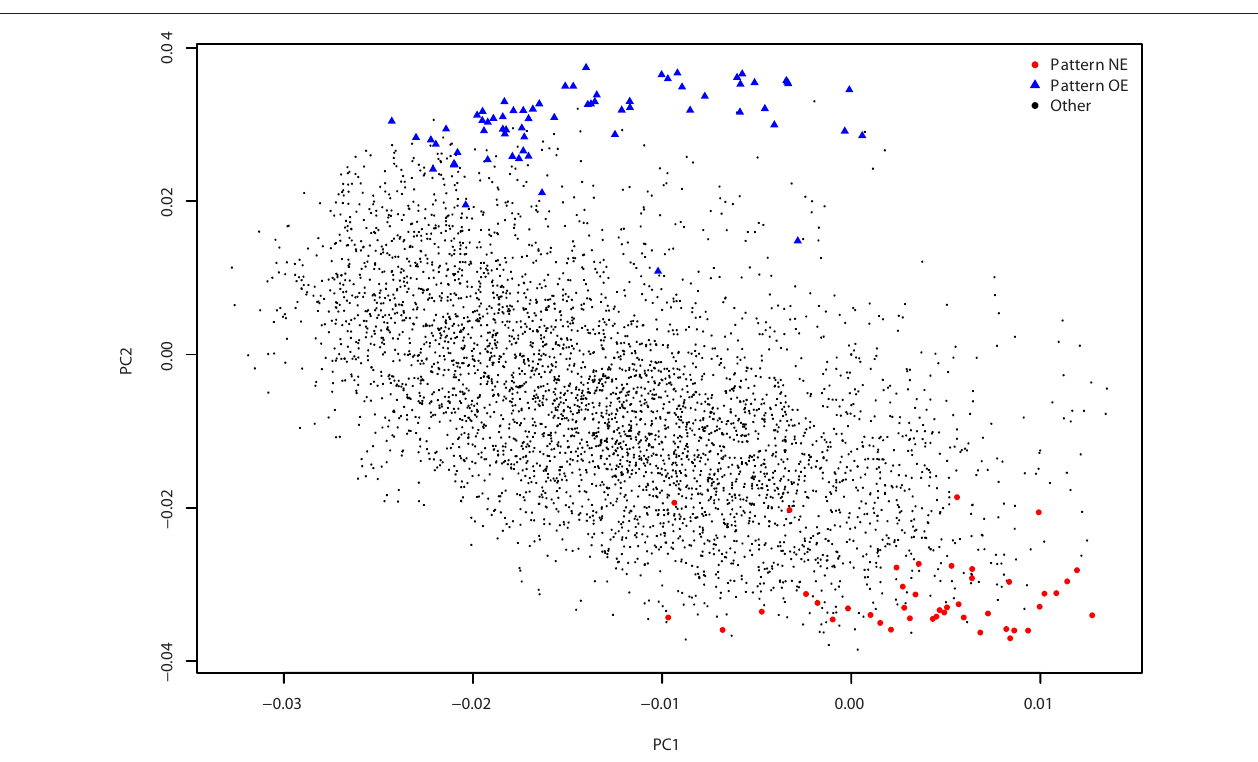
Figure 3 | Principal components analysis. Gene loadings for pattern NE (red circles), pattern OE (blue triangles), and all other genes (small black circles) are plotted. The first two principal components, PC1 (16.4% of the variance) and PC2 (11.8% of the variance), separate the two patterns.